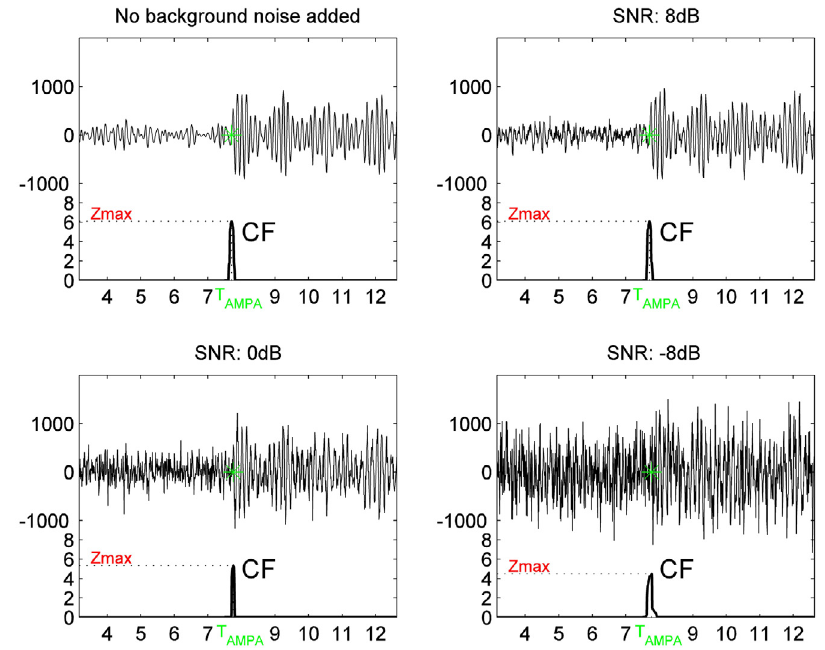
Figure 10. Examples of P-phase picking for an earthquake artificially contaminated with different levels of AWGN. AMPA sets the arrival time at the instant when CF gets its maximum amplitude. The effect of noise can be seen as Z the clean signal (upper left panel) to the most challenging scenario with SNR=−8 dB (lowest right panel).